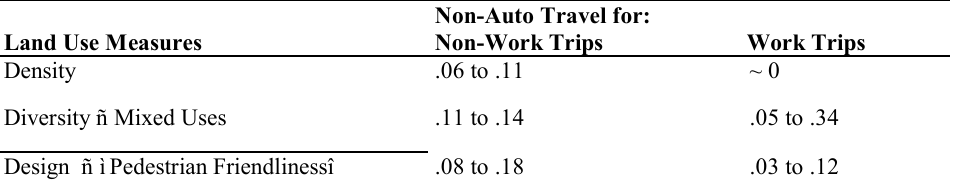
Table 4. Summary Elasticities of Impacts of the Three Dimensions of Built Environments on Travel Choices in the San Francisco Bay Area,